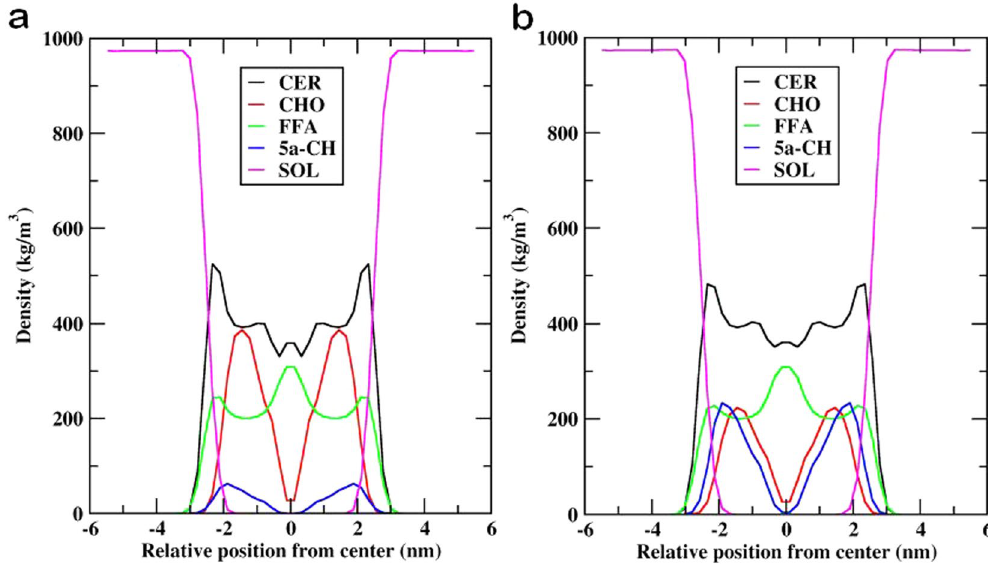
Figure 6. Density profile of individual lipid components (CER-CHO-FFA-5 α -CH) for ( a ) MEMB_12.5; ( b ) MEMB_50 along the bilayer normal (z).